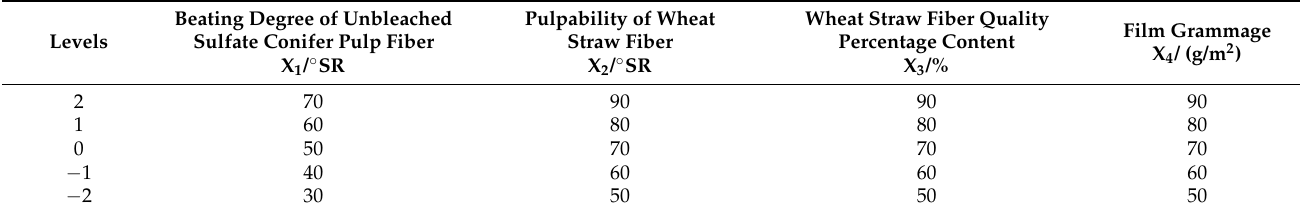
Table 1. Experimental factors coded by levels.